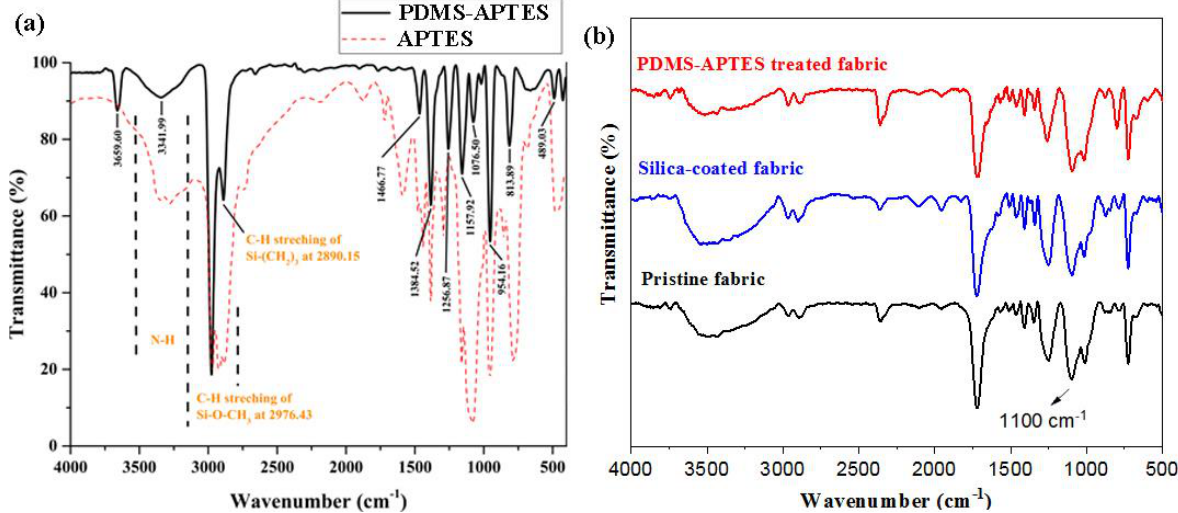
Figure 3. FTIR spectra of ( a ) amino-modified PDMS solution; ( b ) pristine and treated fabrics.